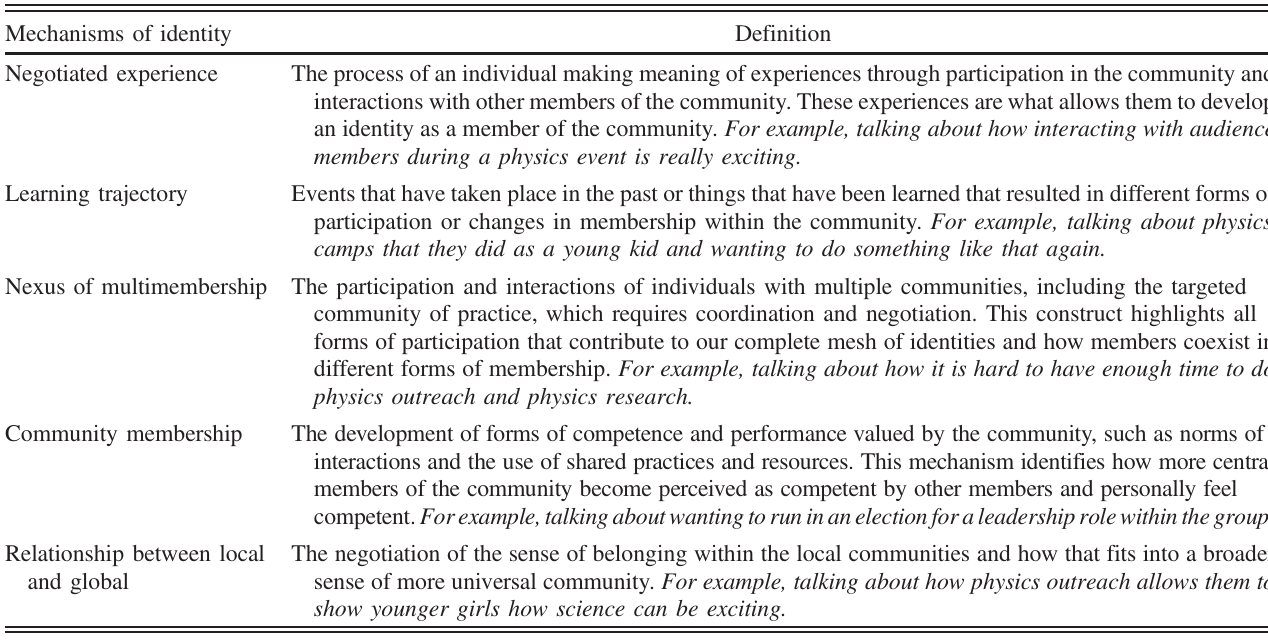
TABLE II. The five mechanisms of identity constructs with definitions and examples from the communities of practice framework. Mechanisms of identity